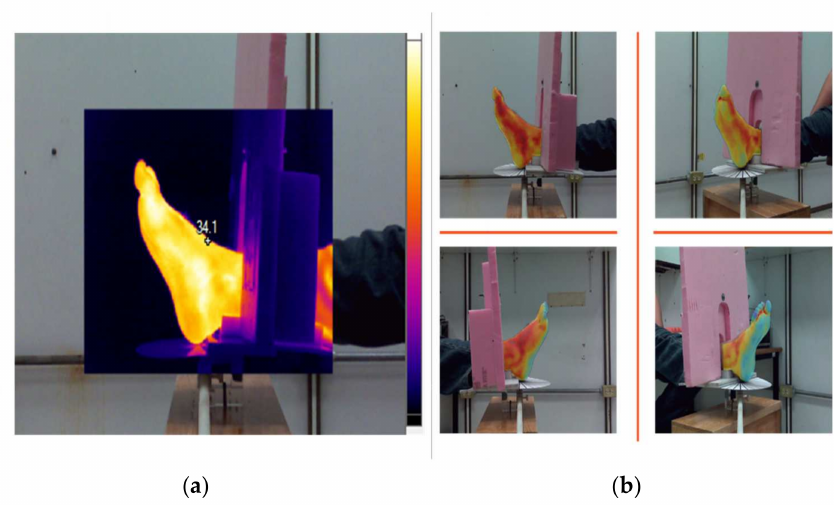
Figure 17. Multimodal image representation: ( a ) SmartView Picture-In-Picture image in which the IR is superimposed on the center of the visible-light image. ( b ) Results of the merged stage, provided by an IR image with a transparent background and the visible-light image as the scene.